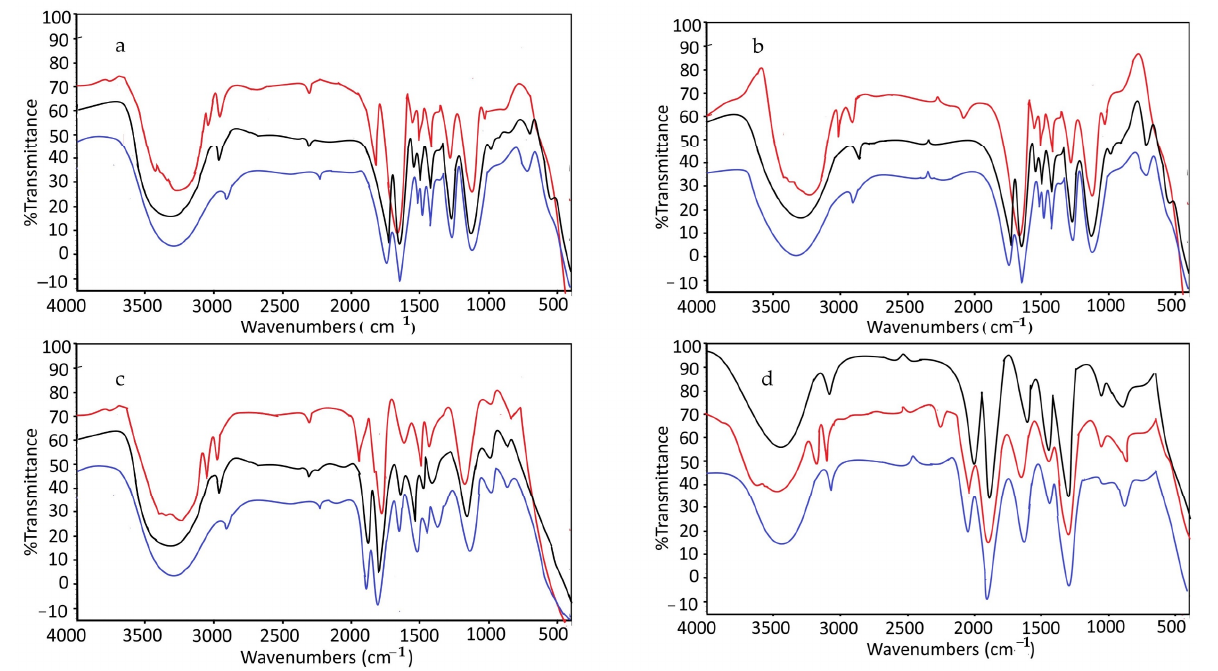
Figure 11. FTIR spectrum of ( a ) MIP1 and NIP1, ( b ) MIP2 and NIP2, ( c ) MIP3 and NIP3, and ( d ) MIP4 and NIP4. Red lines: MIP before extraction, black lines: MIP before extraction, blue lines: NIP.